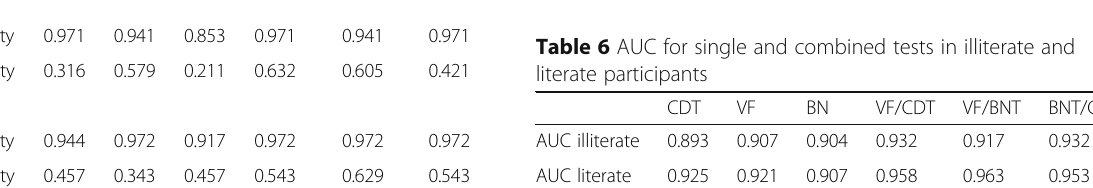
Table 5 Sensitivity and specificity according to education level CDT VF